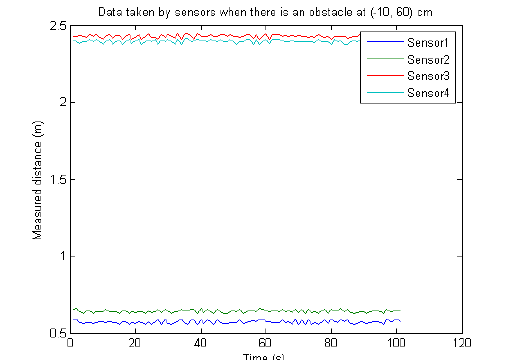
Fig. 7. Measurement results when the obstacle at (-10,60)